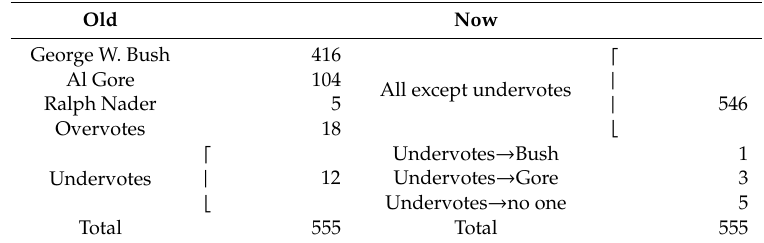
Table 2. Vote tallies for the Alligator Alley precinct (2000 election, Scenario